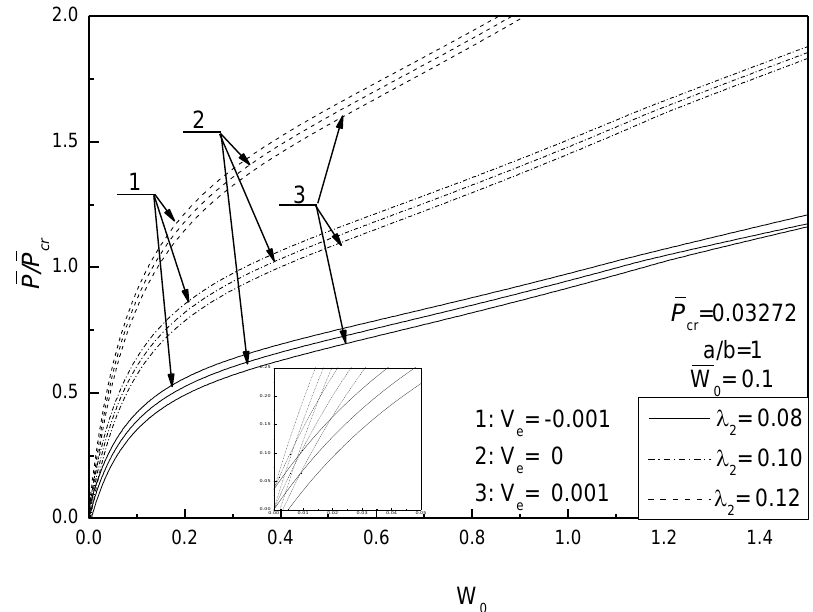
Figure 8. Effect of thick-span ratio on postbuckling response curves of piezoelectric plate without damage under different electrical loads (the inset figure is a zoom-in snapshot of the region around orgin point to depict the difference of three